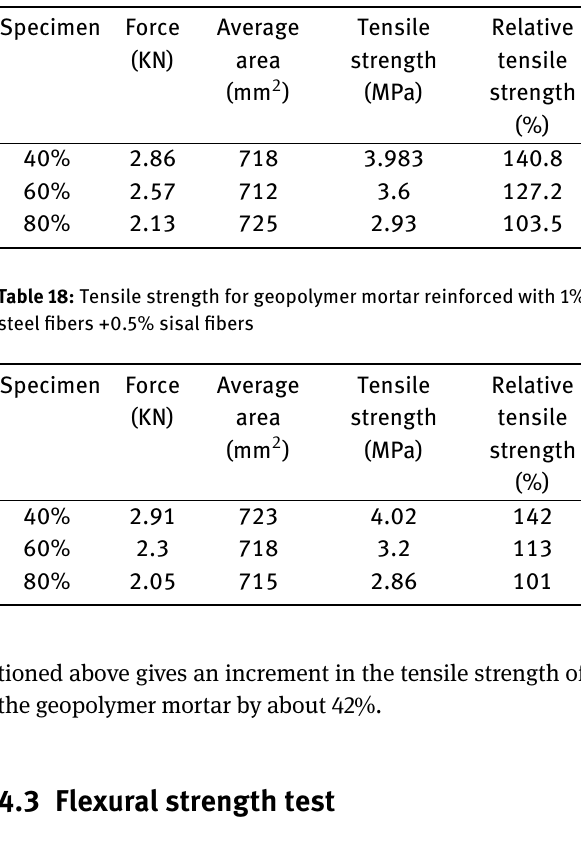
Table 17: Tensile strength for geopolymer mortar reinforced with 1%